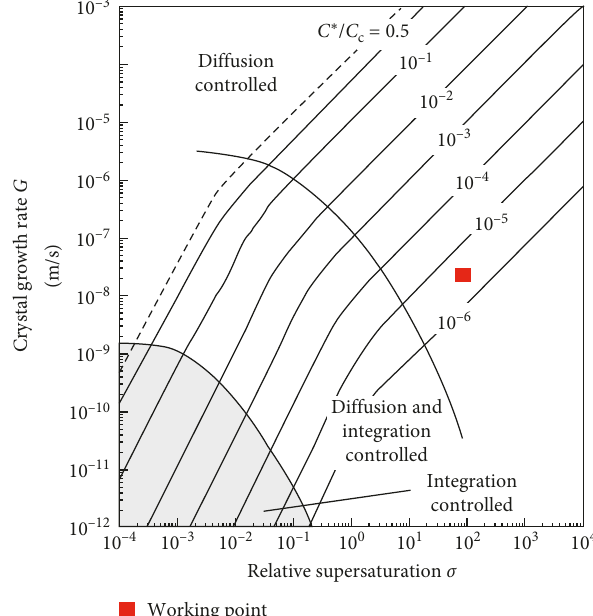
Figure 6: Control mechanisms of crystal growth rate [21] with an additional working point referring to the analyzed process and